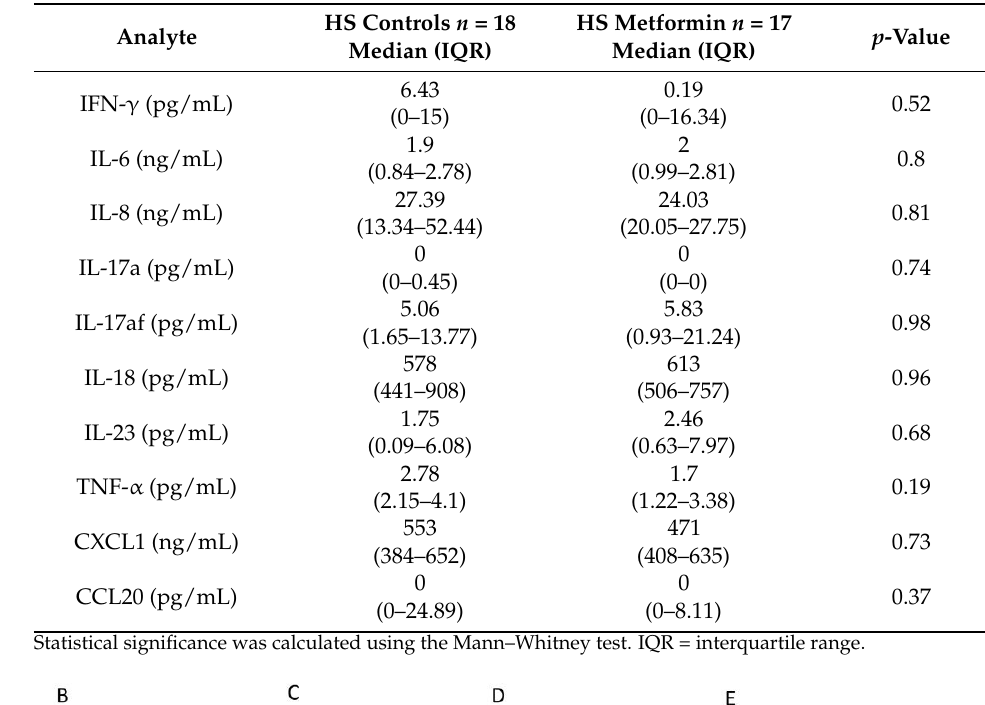
Table 5. Trend towards a reduction in serum concentration of IFN- γ , IL-8, TNF- α , and CXCL1 in HS patients taking metformin compared with HS controls.